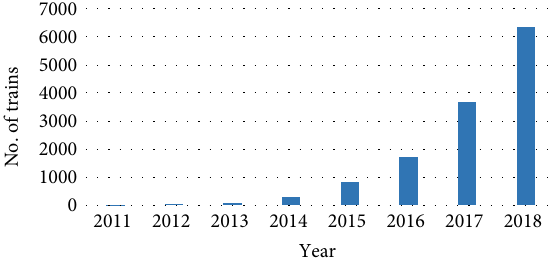
Figure 1: Trend of CRE train volume from 2011 to